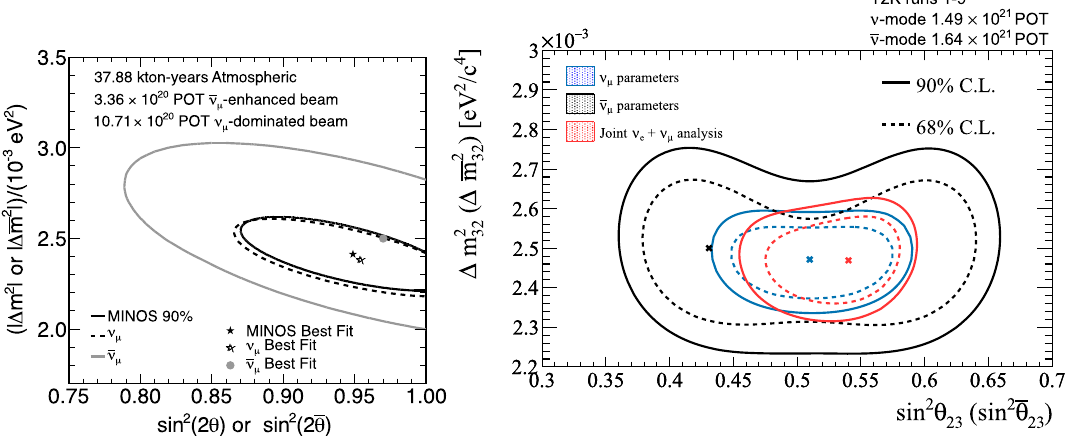
Fig. 7 Muon neutrino and muon anti-neutrino disappearance oscilla- tion fits by MINOS (left) and T2K (right) [391,395]. Note that the MINOS far detector is magnetized to perform charge separations of